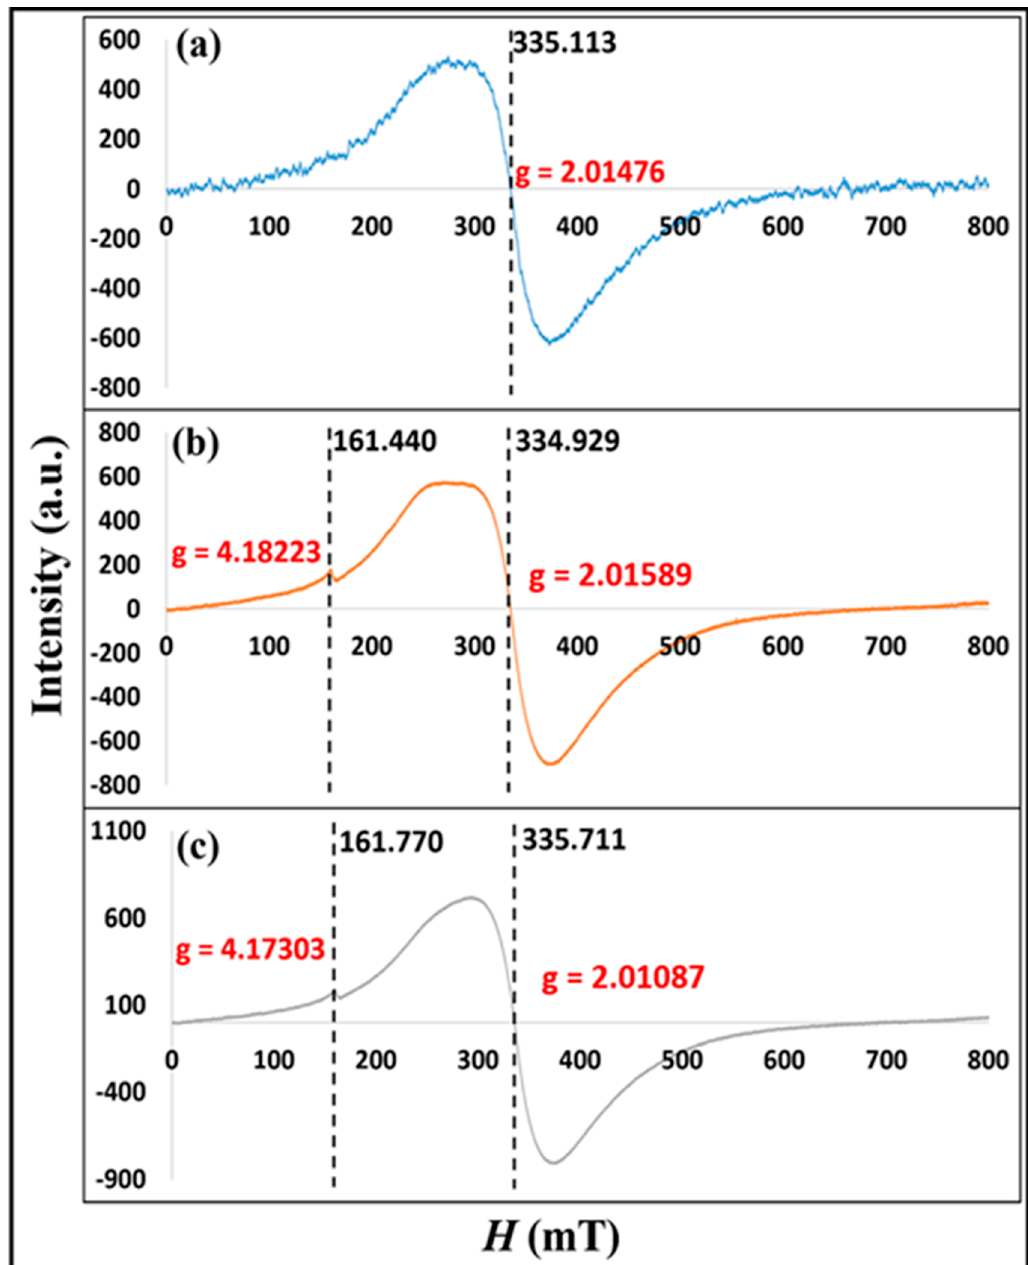
Figure 2. EPR spectra of ( a ) pristine Iron-Z-A, ( b ) P-adsorbed Iron-Z-A, and ( c ) P-desorbed Iron-Z-A.